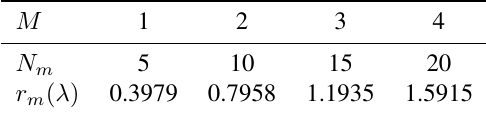
Table 1: Ring radius and number of elements per ring